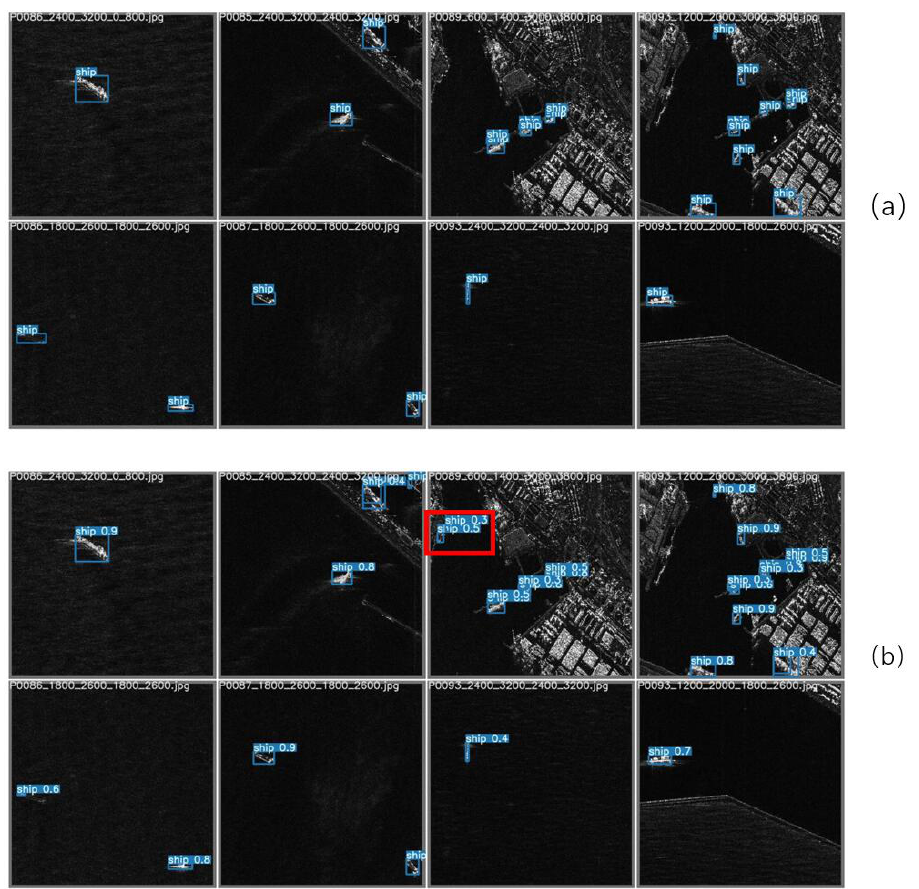
Figure 18. The visual analysis of the detection result of the proposed FASC-Net. ( a ) SAR images and labels. ( b ) The detection